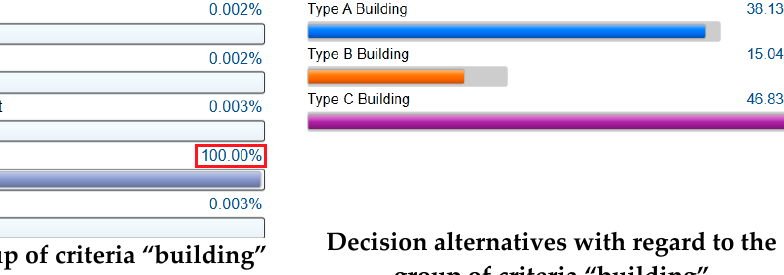
Figure 8. Relevance ranking (%) of sub-criteria of the group of criteria “building” with regard to the choice of adequate office space for BPO tenants with “sustainability and energy efficiency” ranked at 100%.